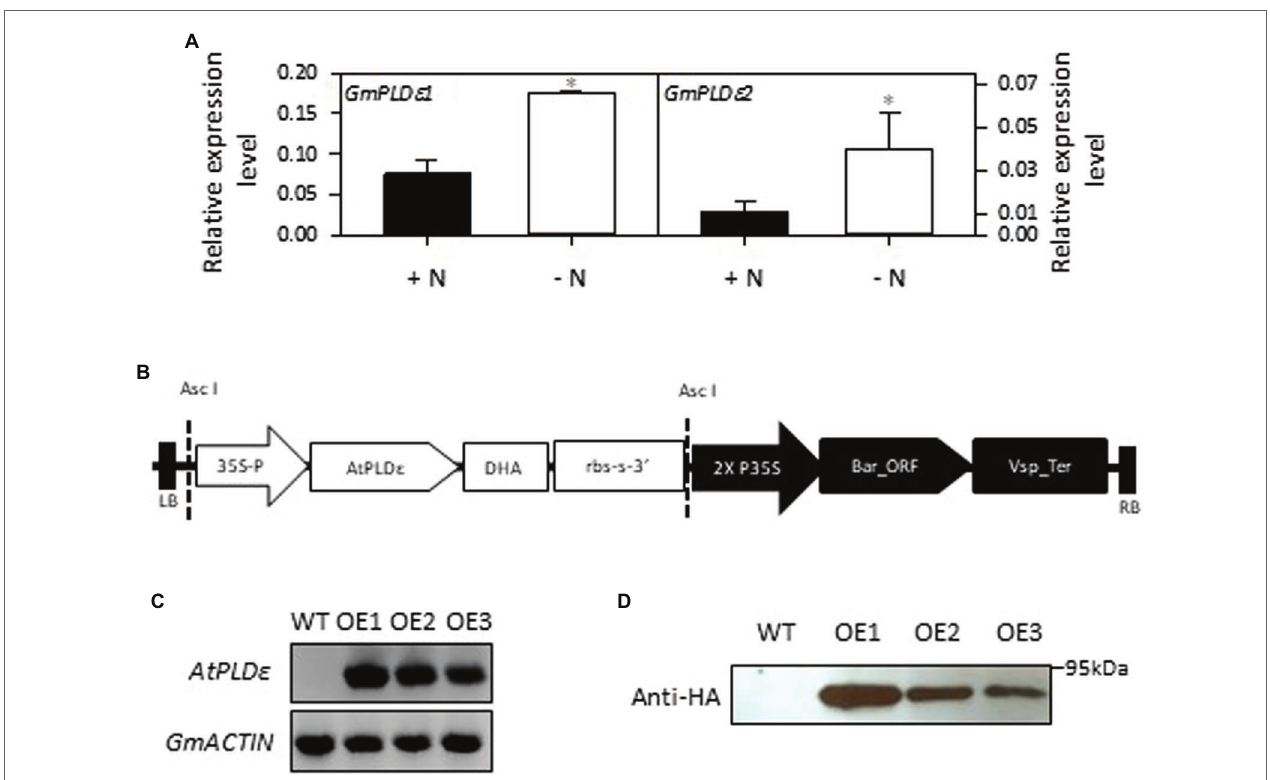
FIGURE 1 | Generation and verification of AtPLD ε -overexpressing soybean plants. (A) RT-qPCR analysis of relative expression level of GmPLD ε 1 and GmPLD ε 2 in the leaves of WT under nitrogen-sufficient and -deficient conditions. Two-week-old soybeans grown on nitrogen rich liquid medium were transferred to nitrogen rich (6 mM N) or free (0 mM) liquid medium for 7 days. The values are means ± SD ( n =3). One asterisk indicates statistical differences compared with nitrogen sufficient conditions determined by student’s t test ( p < 0.05). (B) Schematic diagram of the binary vectors used to overexpress AtPLD ε in soybean. Full-length coding region of AtPLD ε was fused with a HA tag at the 3 ′ end, and then cloned into a binary vector PZY101 under the control of the CaMV 35S promoter. The Basta resistance gene was used as the selectable marker. The T-DNA left border (LB) and right border (RB) are shown. (C) Expression of AtPLD ε in wildtype (cultivar Williams 82) and three independent transgenic soybean lines were determined by semi-quantitative RT-PCR. (D) Immunoblotting detection of hemagglutinin (HA)-tagged AtPLD ε in WT and AtPLD ε OE soybean